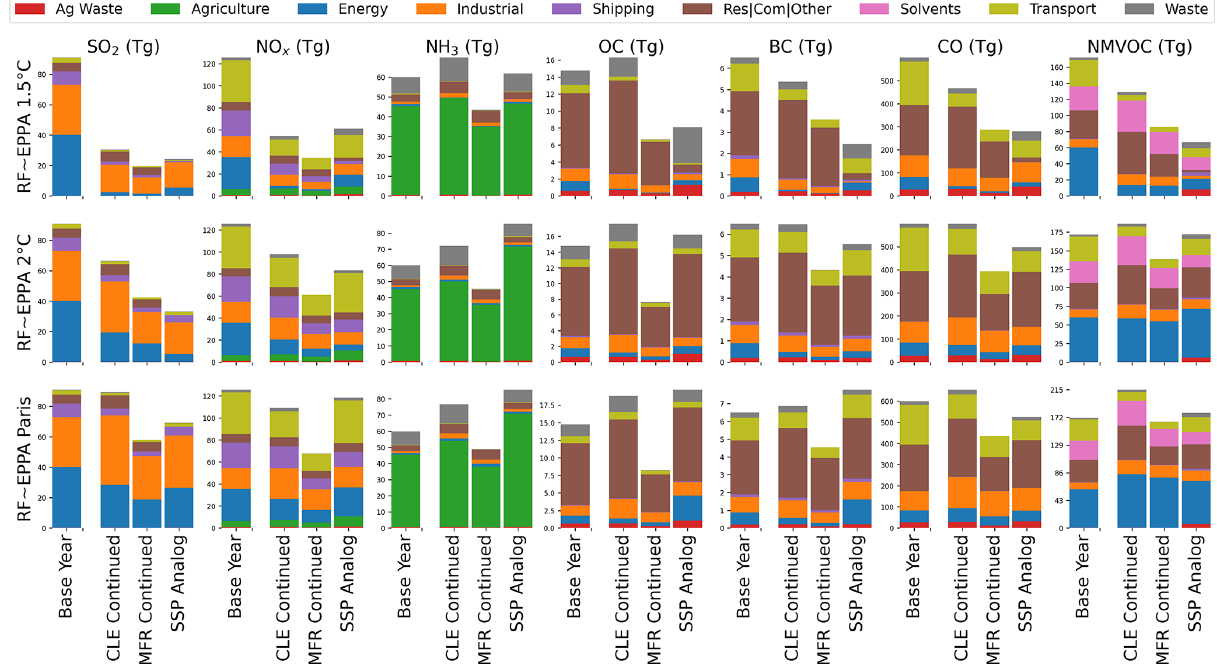
Figure 3. Sectoral emissions of air pollutants in 2050 under the GAINS-based scenarios of current legislation (CLE) and maximum feasible reduction (MFR) continued – along with the 2014 emissions inventories and corresponding CMIP6 scenarios of SSP1-2.6, SSP4-3.4, and SSP4-6.0 (respectively) for EPPA’s 1.5, 2 ◦ C, and Paris Forever scenarios (see Table 2). The 11 CEDS GBD-MAPS sectors (McDuffie et al., 2020a) are condensed to the 8 in the earlier version used by the SSPs (Hoesly et al., 2018), including the aggregation of residential, commercial, and other combustion (“Res|Com|Other”), plus agricultural waste burning (“Ag Waste”) from GFED. Quantities of NO x are in Tg NO 2 ; BC, OC, and NMVOC are in